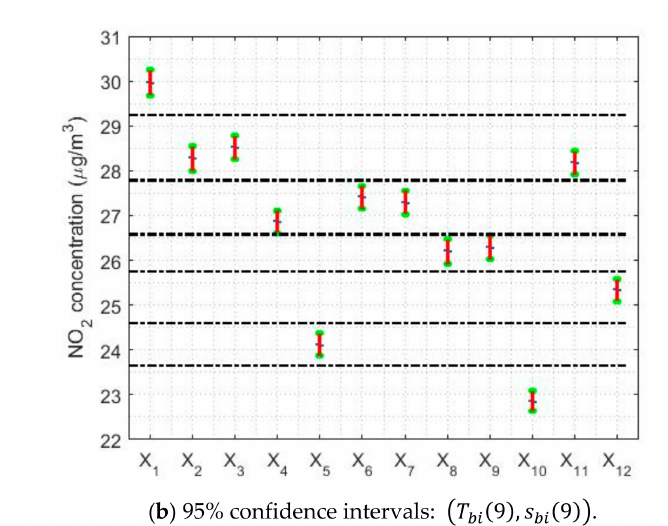
Figure 20. 95% confidence intervals by using the pairs of estimators ( T (0.2), s W (0.2)) and ( T bi (9), s bi (9)). Table 5. 95% confidence intervals ( CI 0.95 and confidence interval lengths: ( T (0.2), s W (0.2)) and ( T bi (9), s bi